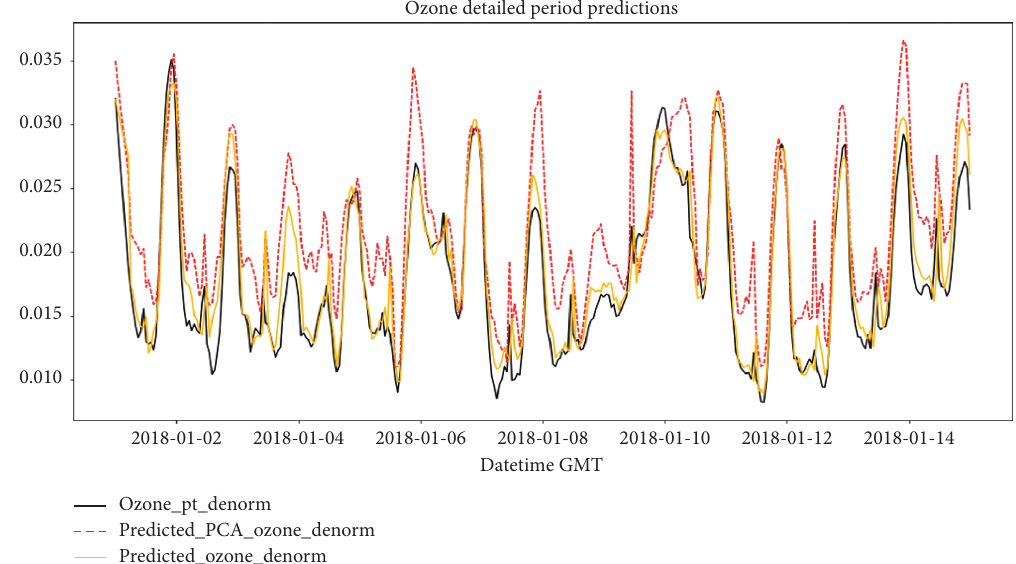
Figure 15: Observed and predicted ozone values for the period between January 1st and January 15th.